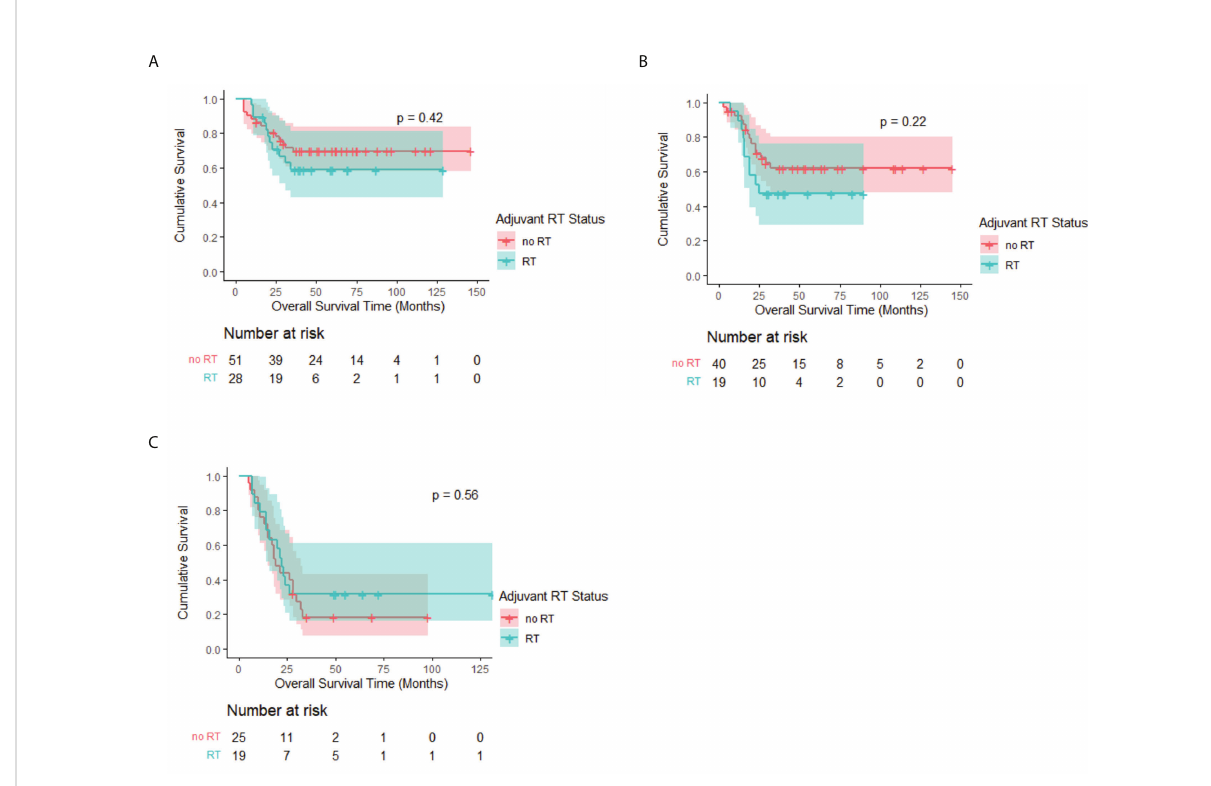
FIGURE 4 Kaplan – Meier OS curve of patients with adenocarcinoma by adjuvant RT status after PSM, strati fi ed by cN stage. Median survival estimates: (A) cN0: Both median OS not reached, p = 0.42. (B) cN1: Both median OS not reached, p = 0.22. (C) cN2 – 3: RT: 22 months (95% CI, 17.7 – 26.3 months) vs . No RT: 19 months (95% CI, 14.1 – 23.9 months), p =